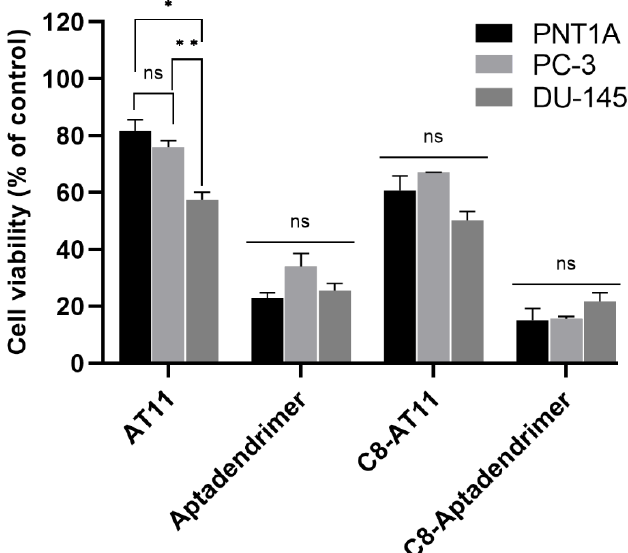
Figure 7. Histograms of cell viability of PNT1A, PC-3 and DU-145 cells after incubation with AT11 (6.6 µM), C 8 -AT11 (6.6 µM AT11 + 0.66 µM C 8 ), aptadendrimer (0.2 µM) and C 8 -aptadendrimer (0.2 µM aptadendrimer + 0.66 µM C 8 ) for 3 days. Results are presented in percentage normalized regard- (0.2 µ M aptadendrimer + 0.66 µ M C 8 ) for 3 days. Results are presented in percentage